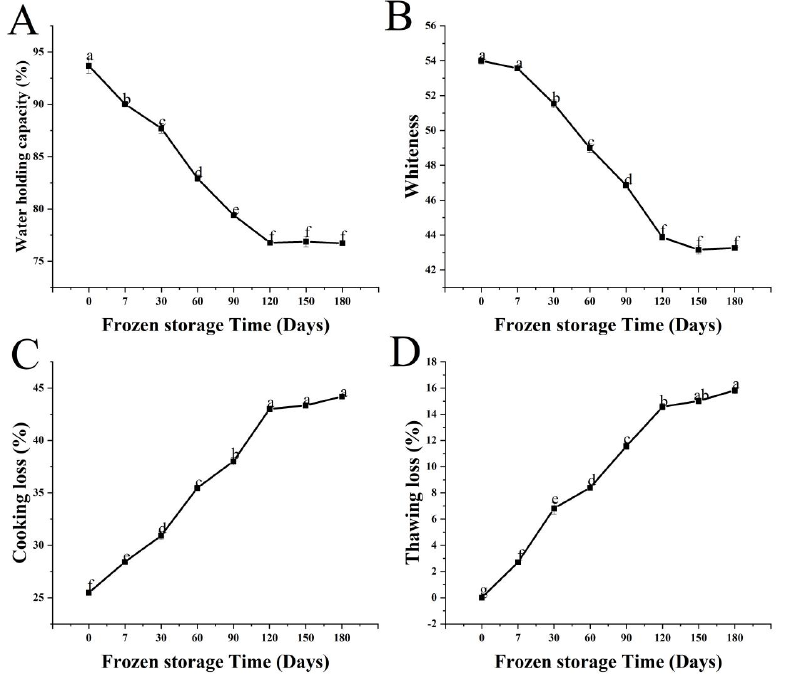
Figure 2. Changes in the water-holding capacity ( A ), whiteness ( B ), cooking loss ( C ), and thawing loss ( D ) of fish sausages during frozen storage. Significant differences between samples ( p < 0.05) are denoted by lowercase letters.